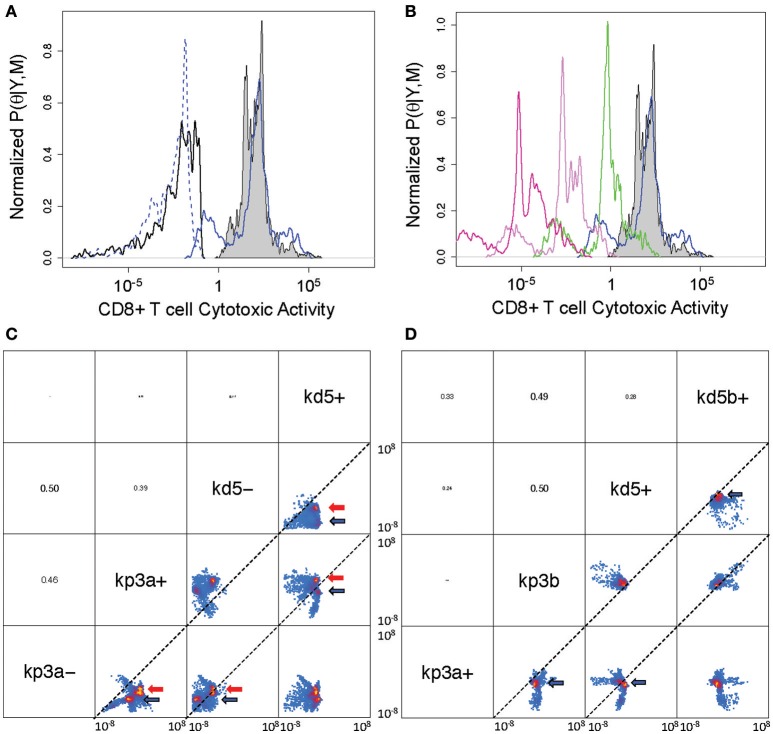
Posterior distribution of parameters associated with cytotoxic killing ability and cell fate within the tumor microenvironment. (A) Posterior density distributions of the parameter values associated with cytotoxic activity of CD8+ T cells, which corresponds to TE3 in the V2 model and TE3a in the V3 model. The parameter values, c4a for TE3 in the V2 model and c4a for TE3a in the V3 model, were determined separately based on rHuAd5-hgp100 and rHuAd5-hDCT vaccination data (c4 for rHuAd5-hgp100: solid black line, c4 for rHuAd5-hDCT: gray shaded, c4a for rHuAd5-hgp100: dotted blue line, c4a for rHuAd5-hDCT: solid blue line). (B) Posterior density distributions of the parameter values associated with the cytotoxic activity of CD8+ T cells following rHuAd5-hDCT vaccination in successive states of deactivation (TE3a: blue line, TE3b: green line, TE3c: indigo line, TE3d: purple line). The distribution in c4 for the V2 model is shown for comparison (gray shaded). (C) Pairwise scatter plots for the rate constants associated with cell proliferation (kp3a- and kp3a+) and cell death (kd5- and kd5+) of newly emigrating CD8+ T cells (TE3 in the V2 model and TE3a in the V3 model). A minus (−) and a plus (+) indicate whether the parameter values were determined using the rHuAd5-hgp100 or rHuAd5-hDCT data, respectively. Parameter values are shown for both the V2 and V3 revised models, where high probability regions are indicated by the red and blue arrows, respectively. The dotted lines indicate where the two parameter have equal values. (D) Pairwise scatter plots for the rate constants associated with cell proliferation (kp3a+ and kp3b) and cell death (kd5+ and kd5b+) of the different states of CD8+ T cells within the tumor. The parameters kp3a+ and kd5+ correspond to TE3a while kp3b and kd5b+ correspond to TE3b, TE3c, and TE3d. In (C,D), parameter names are given on the diagonal. Above the diagonal are the pairwise correlation coefficients of the parameters, where the font size is proportional to the value of the correlation coefficient. Pairwise projections of the marginalized probability density in log10 space are given below the diagonal. Coloring is based upon the estimated 2-D posterior density distributions using kernel density estimation. The axes for the scatter plots each spans from 10−8 to 108.